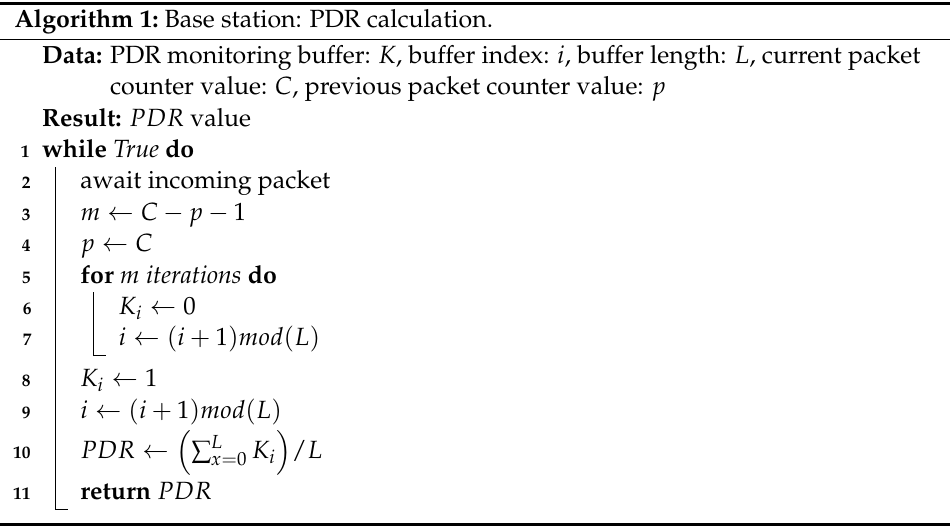
Figure 3. System model and relationship between agent, base station, and node. Algorithm 1: Base station: PDR